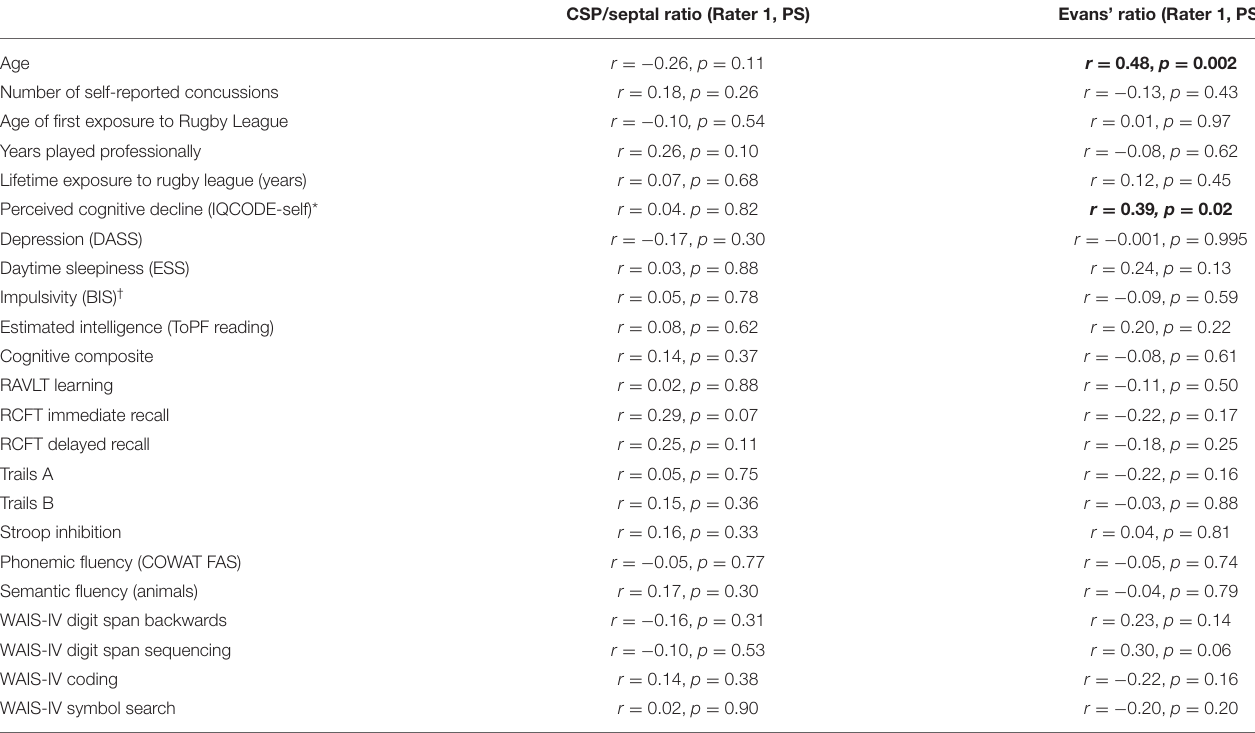
CSP/septal ratio (Rater 1,